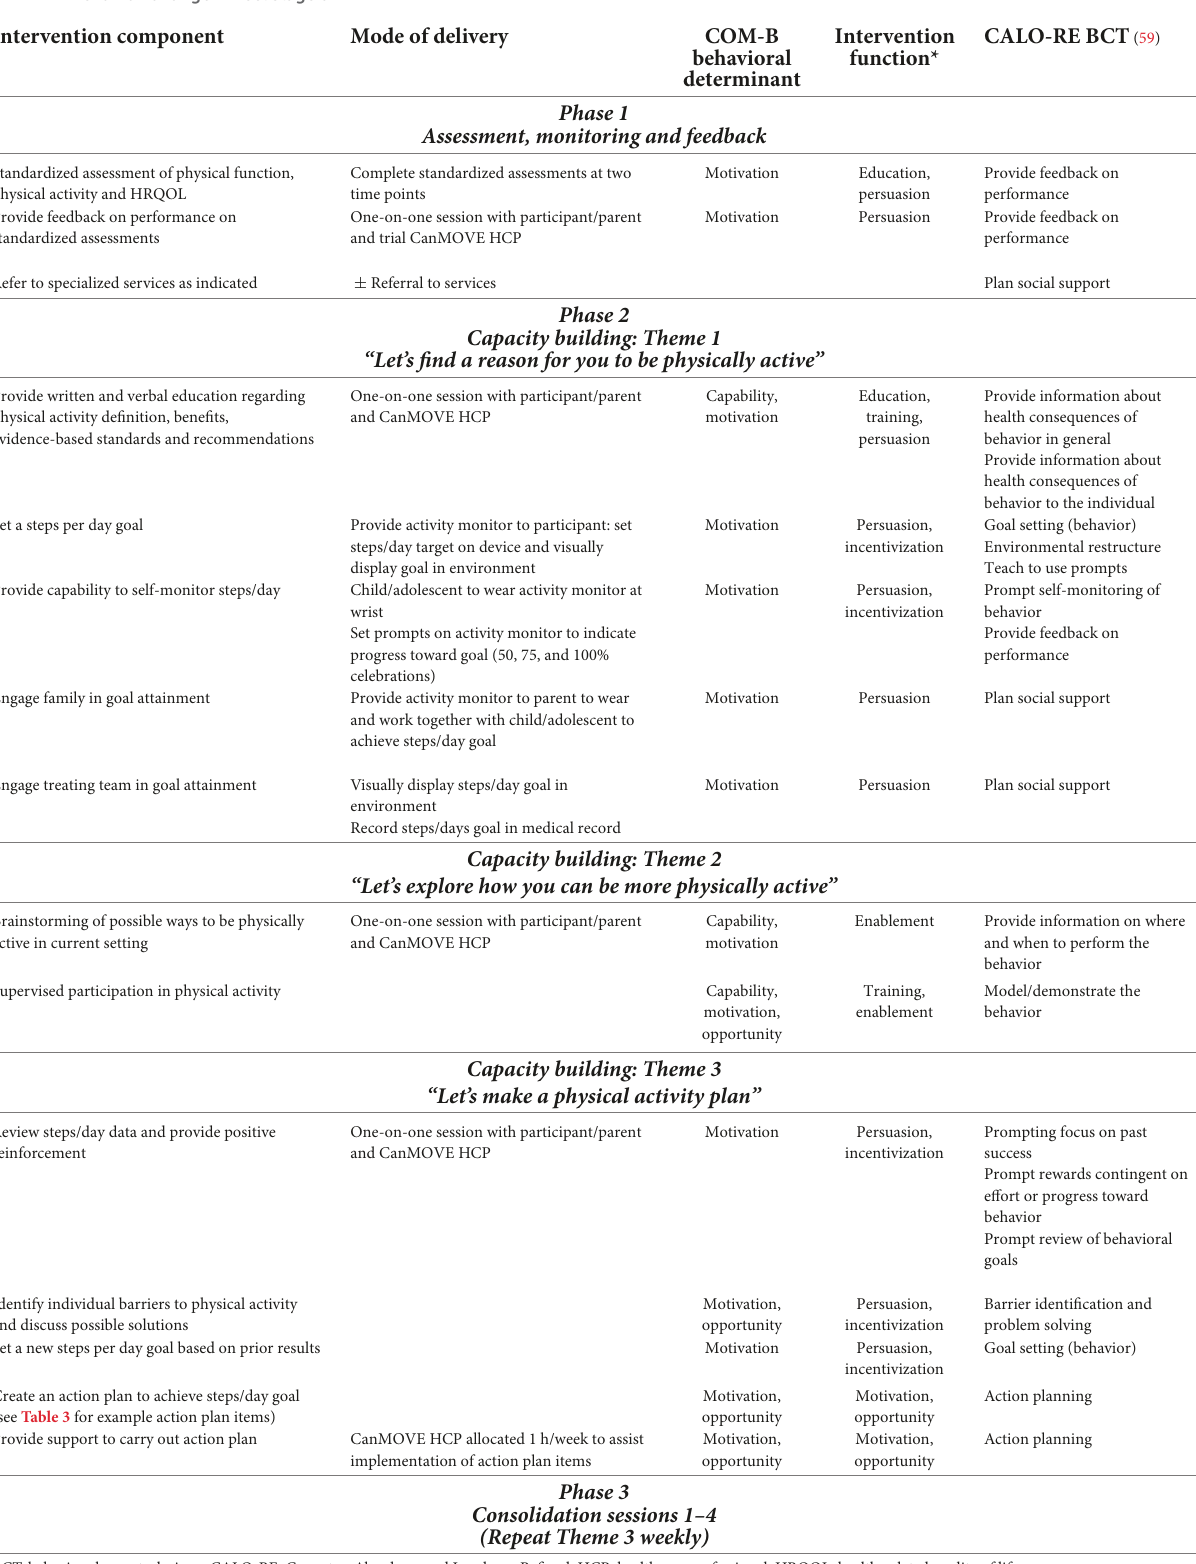
TABLE 2 Behavior Change Wheel stage